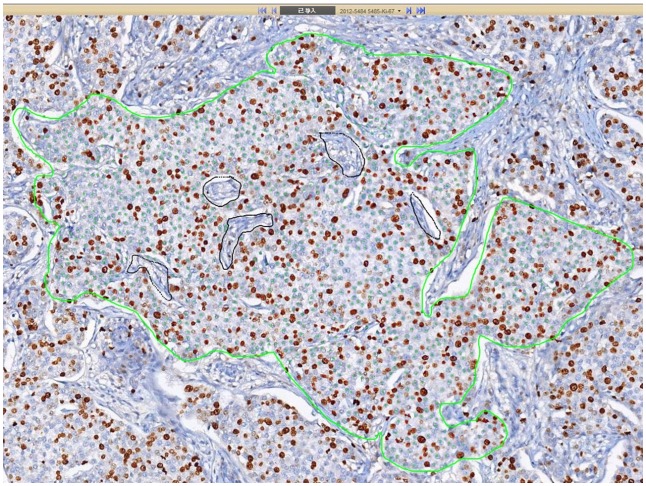
A selected area was to be analyzed by DIA.The scored area was surrounded by green lines and the mesenchymal components were excluded by black lines.